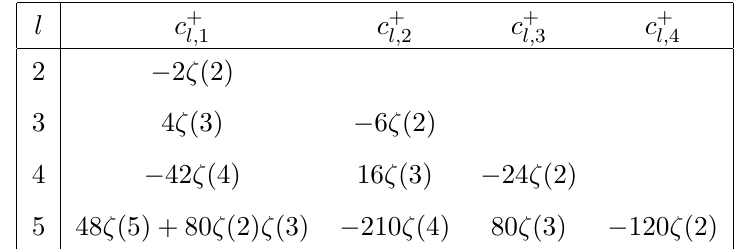
Table 1 . Numerically determined coefficients c +